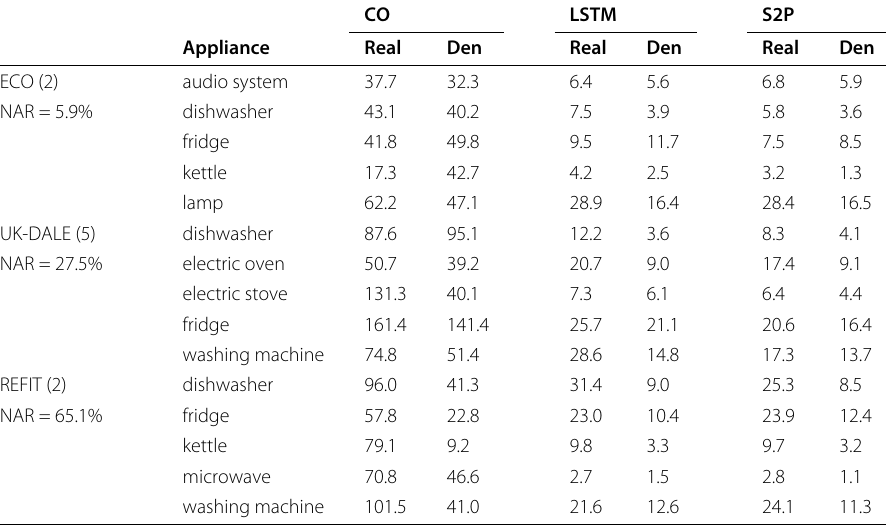
Table 3 Mean absolute error (MAE) in Watts for real and denoised testing